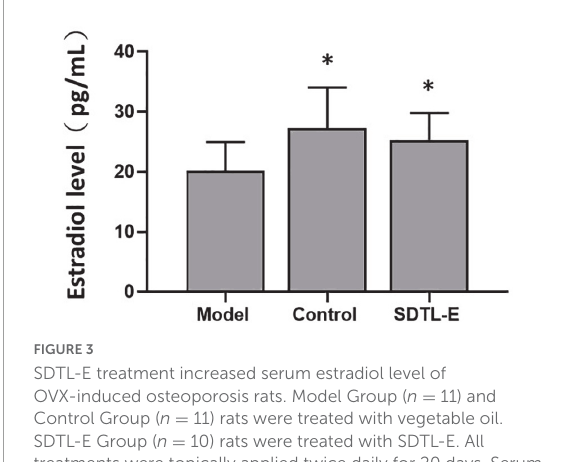
FIGURE3 SDTL-E treatment increased serum estradiol level of OVX-induced osteoporosis rats. Model Group ( n = 11) and Control Group ( n = 11) rats were treated with vegetable oil. SDTL-E Group ( n = 10) rats were treated with SDTL-E. All treatments were topically applied twice daily for 20 days. Serum estradiol levels were determined by estradiol assay. Values are mean ± SD . ∗ p < 0.05 vs. Model Group.